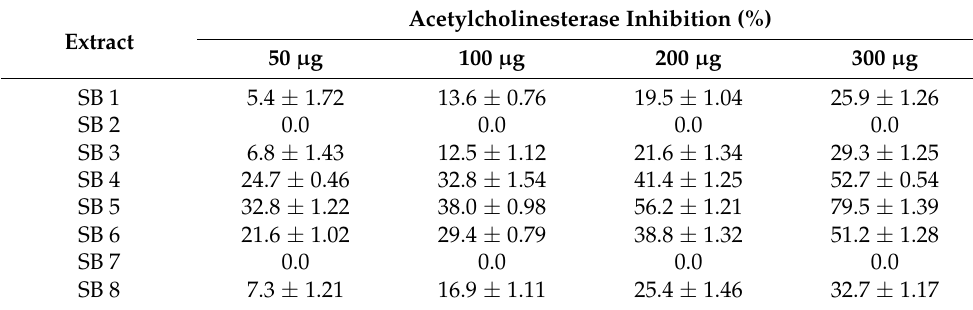
Table 1. Acetylcholinesterase inhibition (%) of different fungal